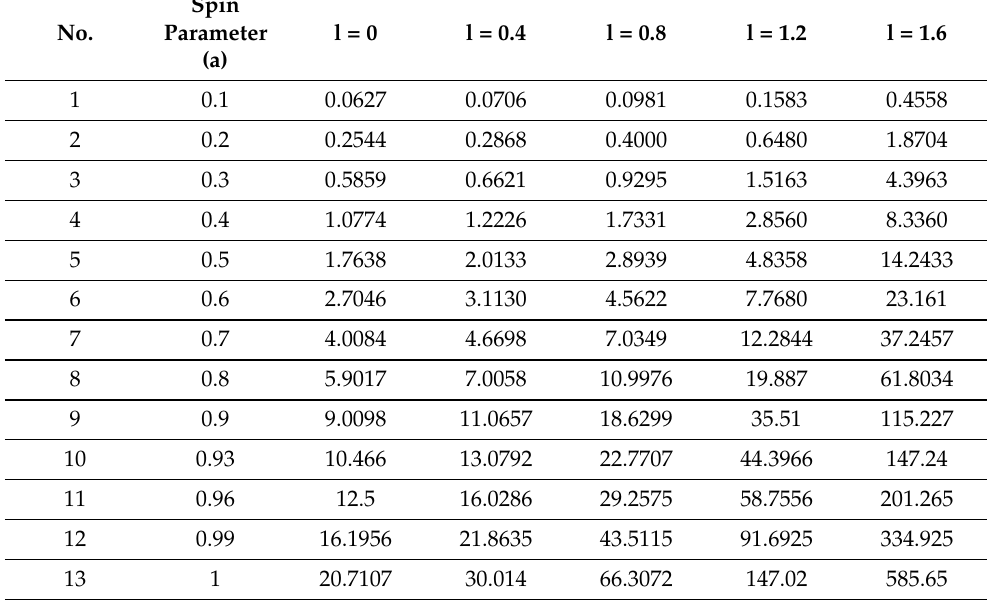
Table 1. In the given table, the efficiency of energy extraction is calculated in a regular black hole spacetime for different l ( 0.4,0.8,1.2,1.6 ) , and comparison with the Kerr black hole is given (l =